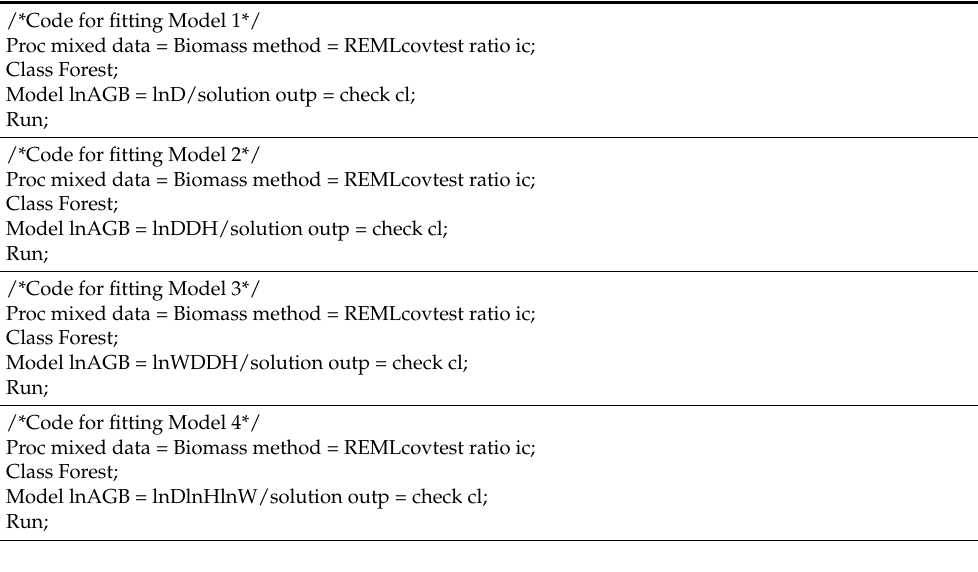
Table A2. PROC MIXED codes for estimating parameters of the LMM